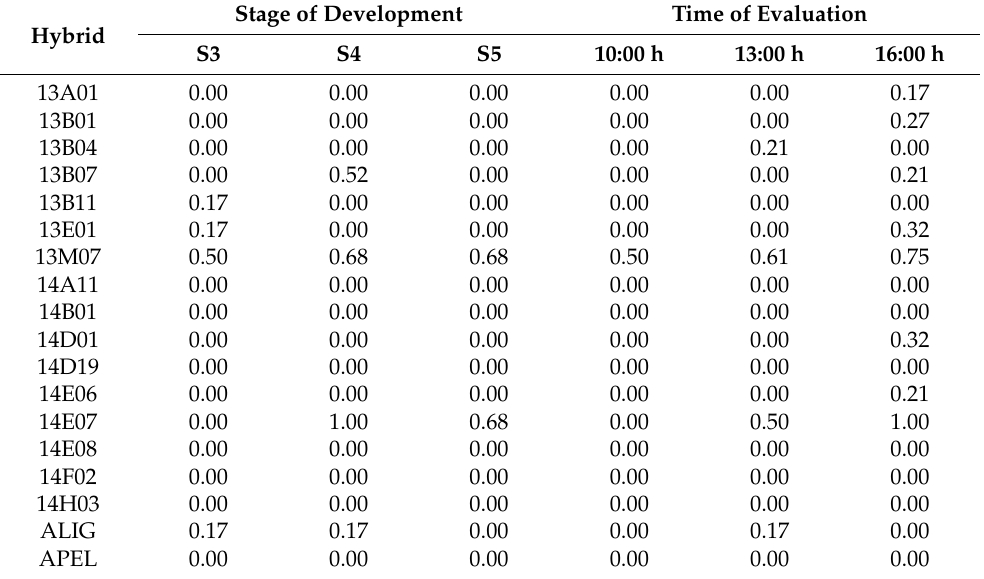
Table A1. Averages obtained for the sensorial analysis of floral scent perceived in alstroemeria hybrids (yes = 1 and no = 0) at different stages of development and different times of evaluation.